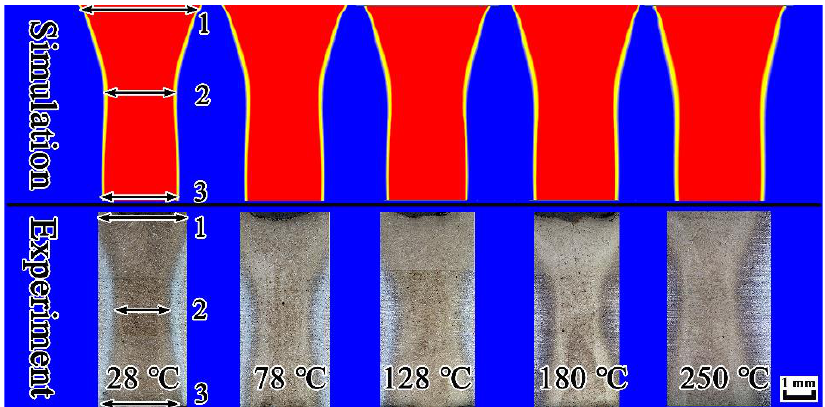
Figure 5. Comparisons of simulated and experimental welding profiles.